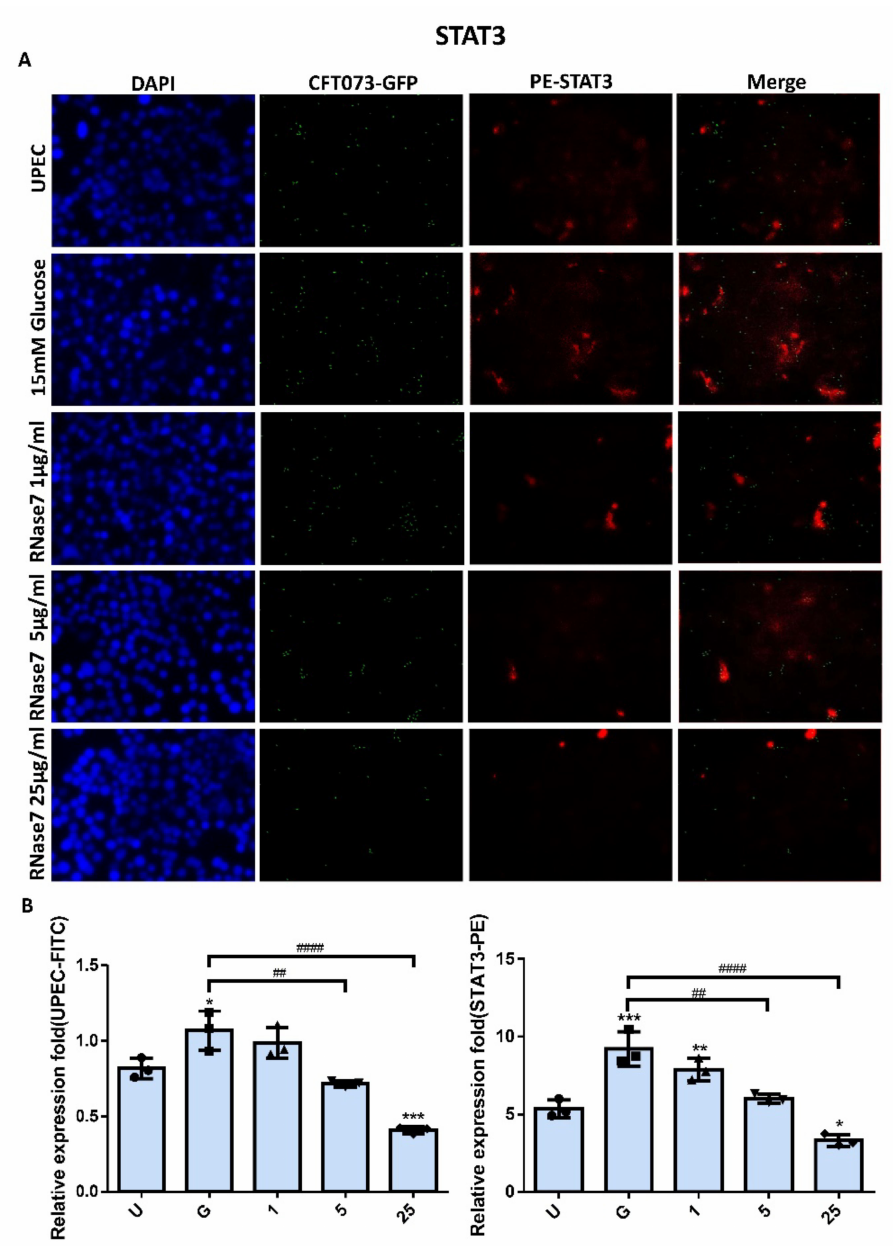
Figure 3. RNase 7 affected UPEC infection and STAT3 expression in bladder cells. After 24 h of pretreatment with different concentrations of RNase 7 (1, 5, and 25 µ g/mL) and 15 mM glucose, GFP- UPEC and PE-STAT3 expression in SV-HUC-1 cells post-infection were ( A ) observed by fluorescence microscopy and ( B ) measured using ImageJ software. Cells infected with UPEC alone were used as the positive controls. The data shown are representative of a typical result. DAPI was used to count the number of cells and as a standard for calculating the fluorescence expression ratio of cells. Cell images were captured using a microscope (Leica) at 100 × magnification. The definitions of each letter/number represented by the X axis are: U: UPEC infection alone; G: with 15 mM glucose pretreatment alone; 1, 5, and 25: pretreated with 1, 5, and 25 µ g/mL RNase 7, respectively, + 15 mM glucose. Data are expressed as the mean ± SD of three independent experiments. * p < 0.05, ** p < 0.01, *** p < 0.001, compared to UPEC infection control groups. ## p < 0.01, #### p < 0.0001, compared between the two